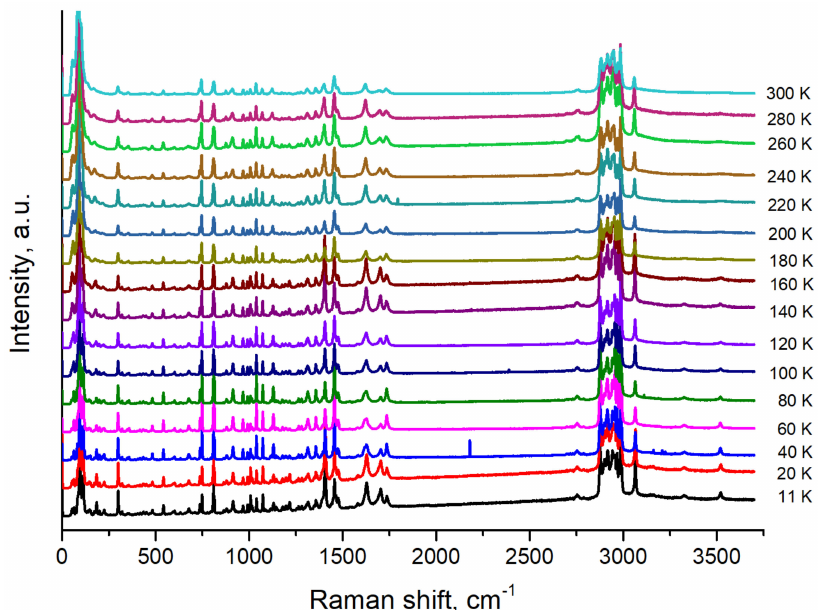
Figure 4. LLHM Raman spectra at low temperatures, showing no phase transition on cooling. Lone spurious peaks in the region of 2000–2500 cm − 1 at temperatures 40 and 100 K were not vanished from spectra to preserve original data. Same is true for spurious peaks at 40 K in the region between 3100–3250 cm − 1